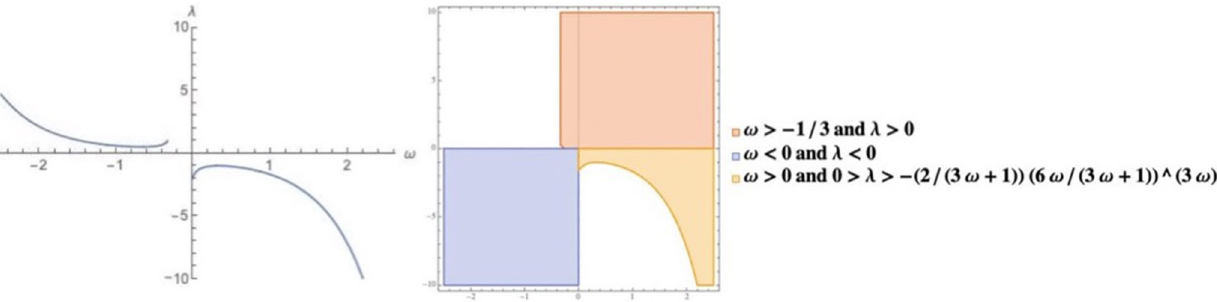
temperature would be negative. In addition to these 2 graphs, we have also two special case: (1) ω = 0, so λ > − 2, and (2) ω = − 1 / 3, so λ <